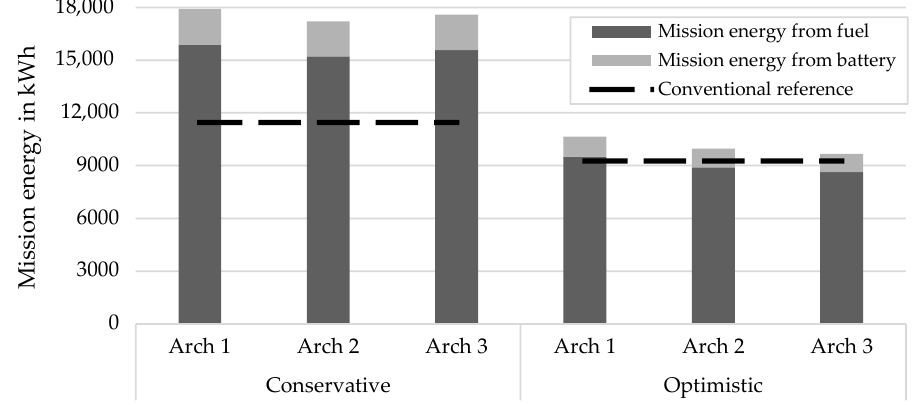
Figure 8. Comparison of the mission energy for the parallel hybrid-electric Architectures 1, 2 and 3. Mission energy includes the regular and the reserve